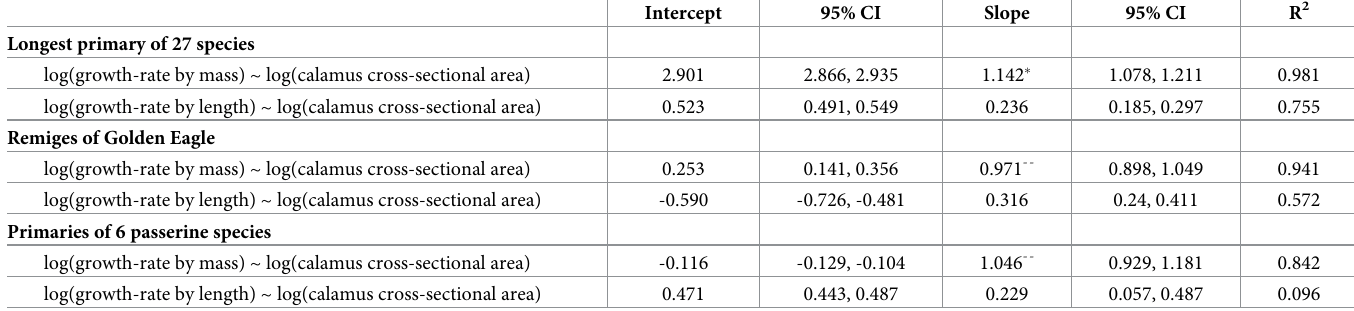
Table 1. Reduced major axis regressions between feather growth-rate by mass, and alternatively feather growth-rate by length, and the cross-sectional area of the calamus as a proxy of feather follicle